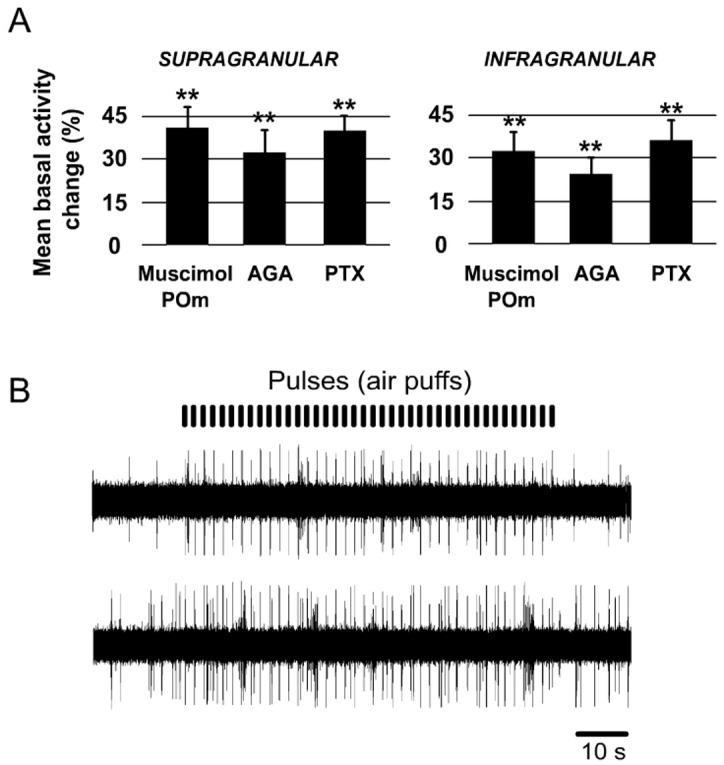
Cortical spontaneous activity changes in different tested conditions.(A) Mean basal activity change (%) in different conditions (muscimol in POm; AGA and PTX in cortical surface). In all conditions cortical basal activity in S1 was significantly increased after drugs applications. The baseline firing rate was calculated from mean firing within a 10 s window before the first pulse (air puff). (B) Muscimol-induced inactivation of the POm enhanced sensory responses in infra- and supragranular layers and increased cortical spontaneous activity. Raw cortical extracelular recordings are shown before (top) and after (bottom) muscimol application. These recordings show the enhancement of cortical sensory responses to whisker deflections (pulses). Cortical spontaneous activity was also increased after muscimol-induced inactivation of the POm.